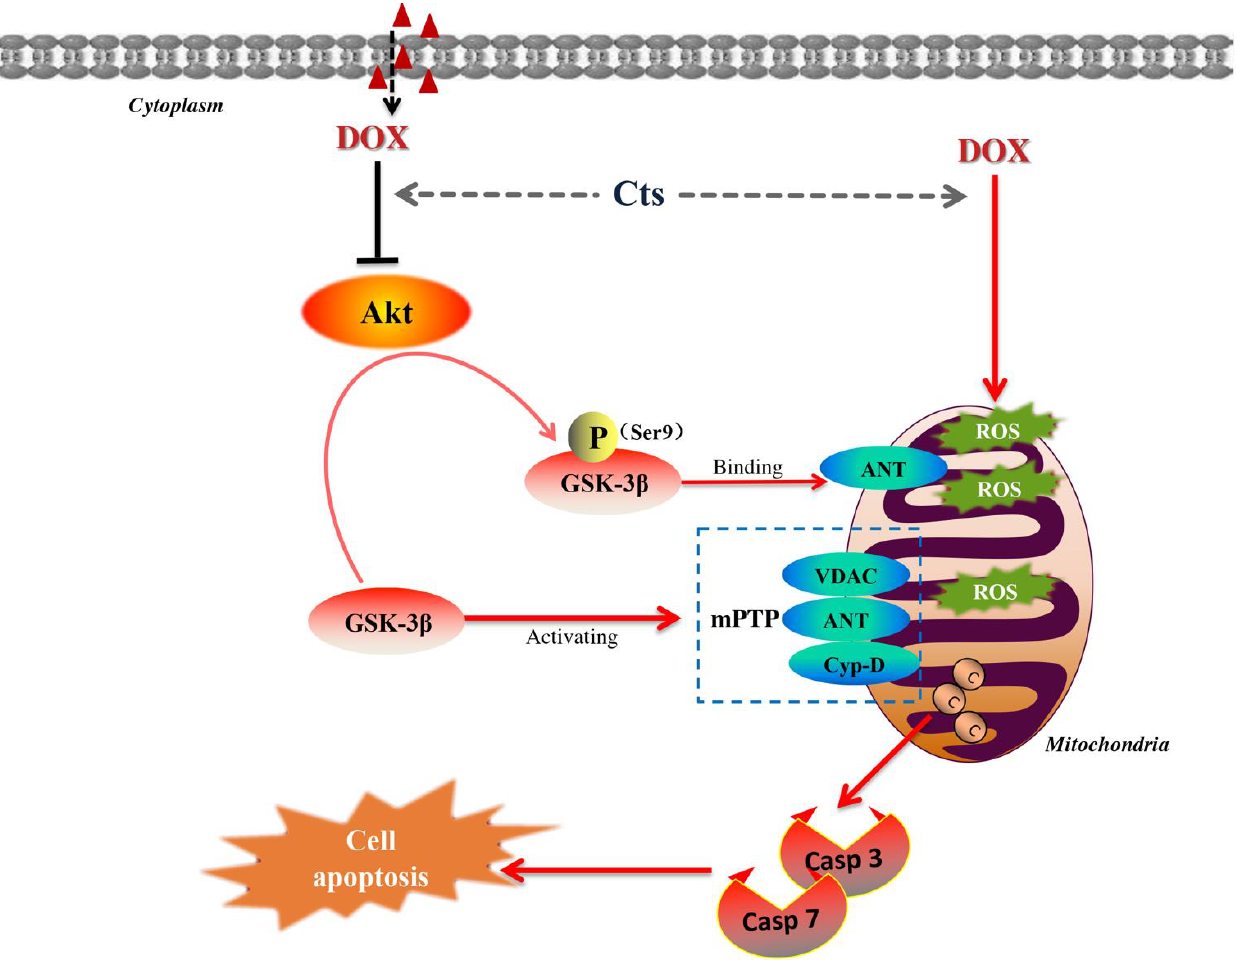
Figure 6. The effects of Cryptotanshinone (Cts) on the Akt-GSK-3 β -mPTP signaling pathway. The level of reactive oxygen species (ROS) was up-regulated by Doxorubicin (Dox)-stimulation. Cts could reduce ROS level, down-regulate caspase 3 (Casp3) and caspase 7 (Casp7) activity, and inhibit cell apoptosis. The mitochondrial permeability transition pore (mPTP) is made of three key components, including ANT, CypD and VDAC. Cts could rescue the opening of mPTP by inhibiting CypD-ANT interaction and increasing p-GSK-3 β -ANT interaction. In conclusion, Cts could ameliorate oxidative stress and apoptosis via the Akt-GSK-3 β -mPTP pathway.